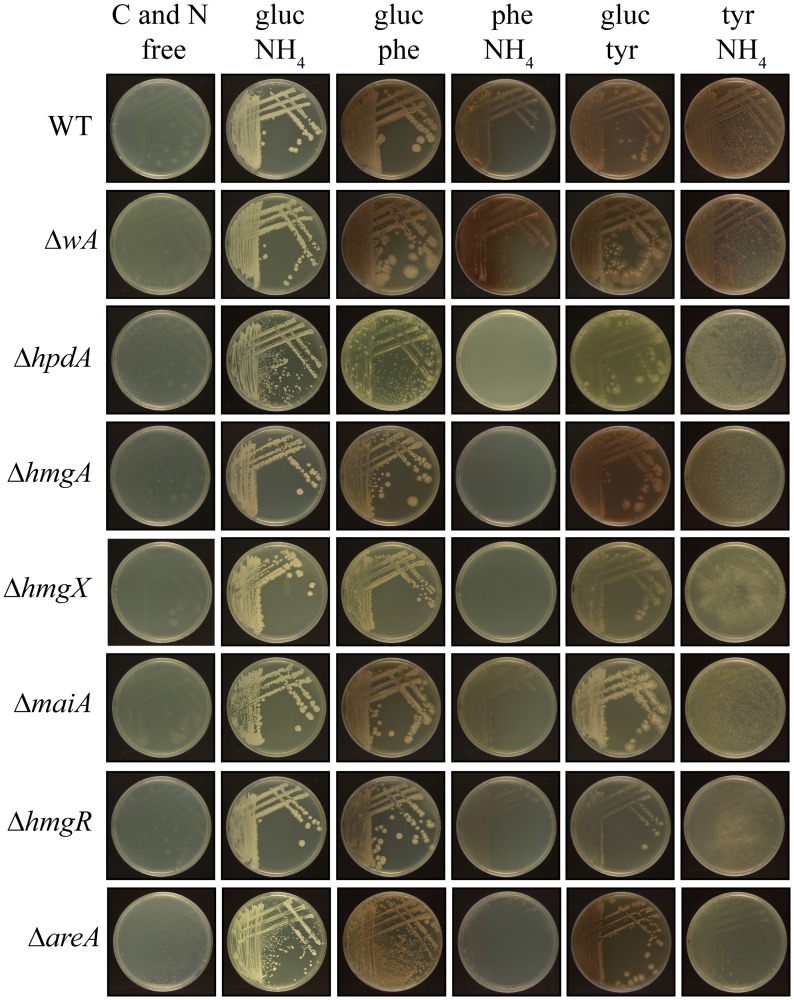
Growth of yeast cells on tyrosine and phenylalanine as a nitrogen or carbon source at 37°C requires genes of the tyrosine catabolic cluster.Growth after 14 days at 37°C of the wildtype, ΔwA, ΔhpdA, ΔhmgA, ΔhmgX, ΔmaiA, ΔhmgR and ΔareA strains on carbon and nitrogen free medium (C and N free), on ammonium as the sole nitrogen source (gluc NH4), on phenylalanine as the sole nitrogen source (gluc phe), on phenylalanine as the sole carbon source (phe NH4), on tyrosine as the sole nitrogen source (gluc tyr) or on tyrosine as the sole carbon source (tyr NH4).